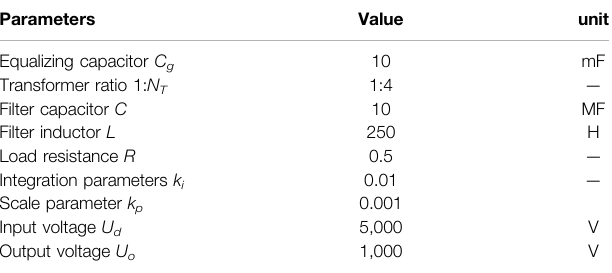
Frontiers in Energy Research |